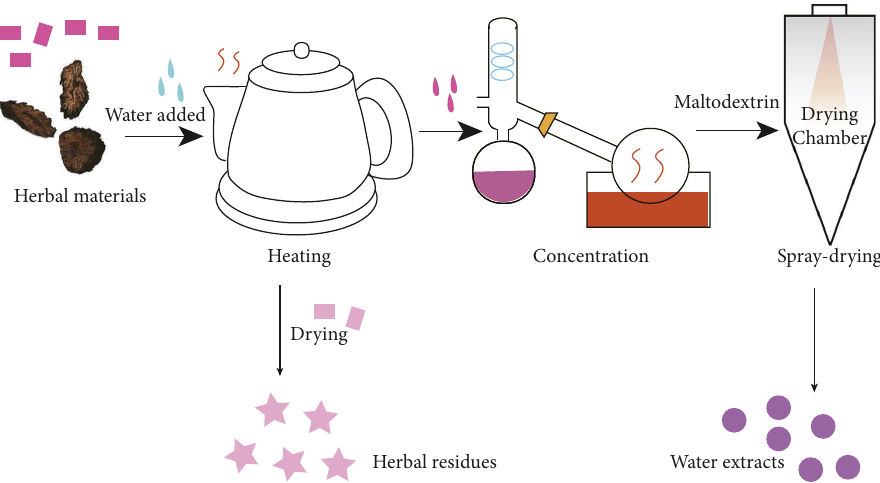
Figure 1: Te procedure of processing raw materials of C. tubulosa into diferent